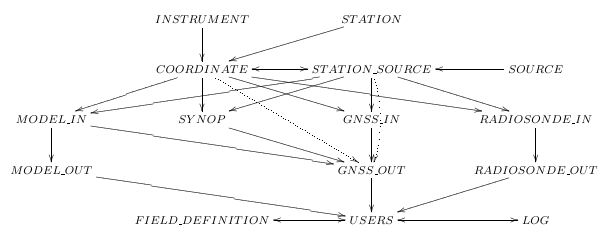
Figure 1. SUADA data structure and data flow. Fig.1. SUADAdatastructureanddataflow. figure